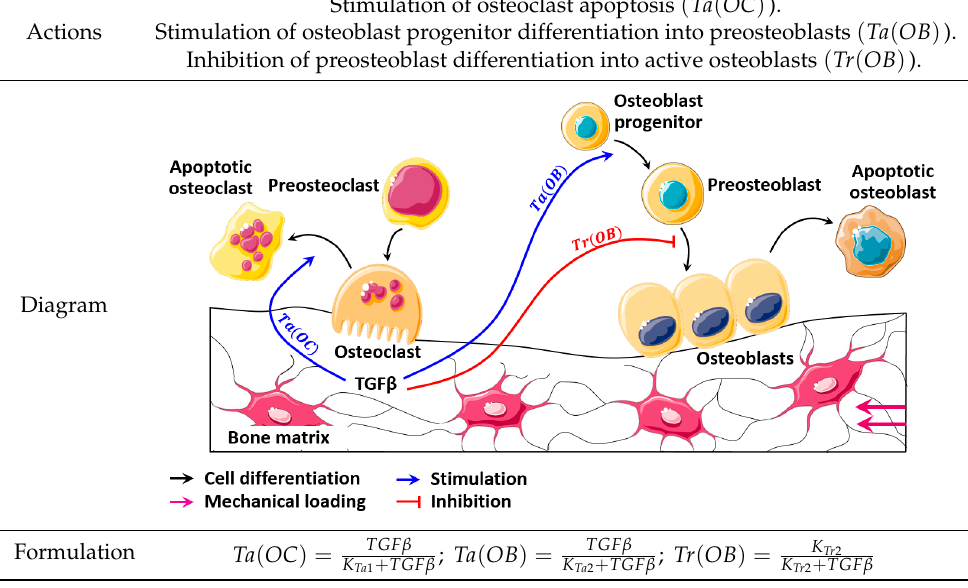
Table 1. TGF β actions and their mathematical